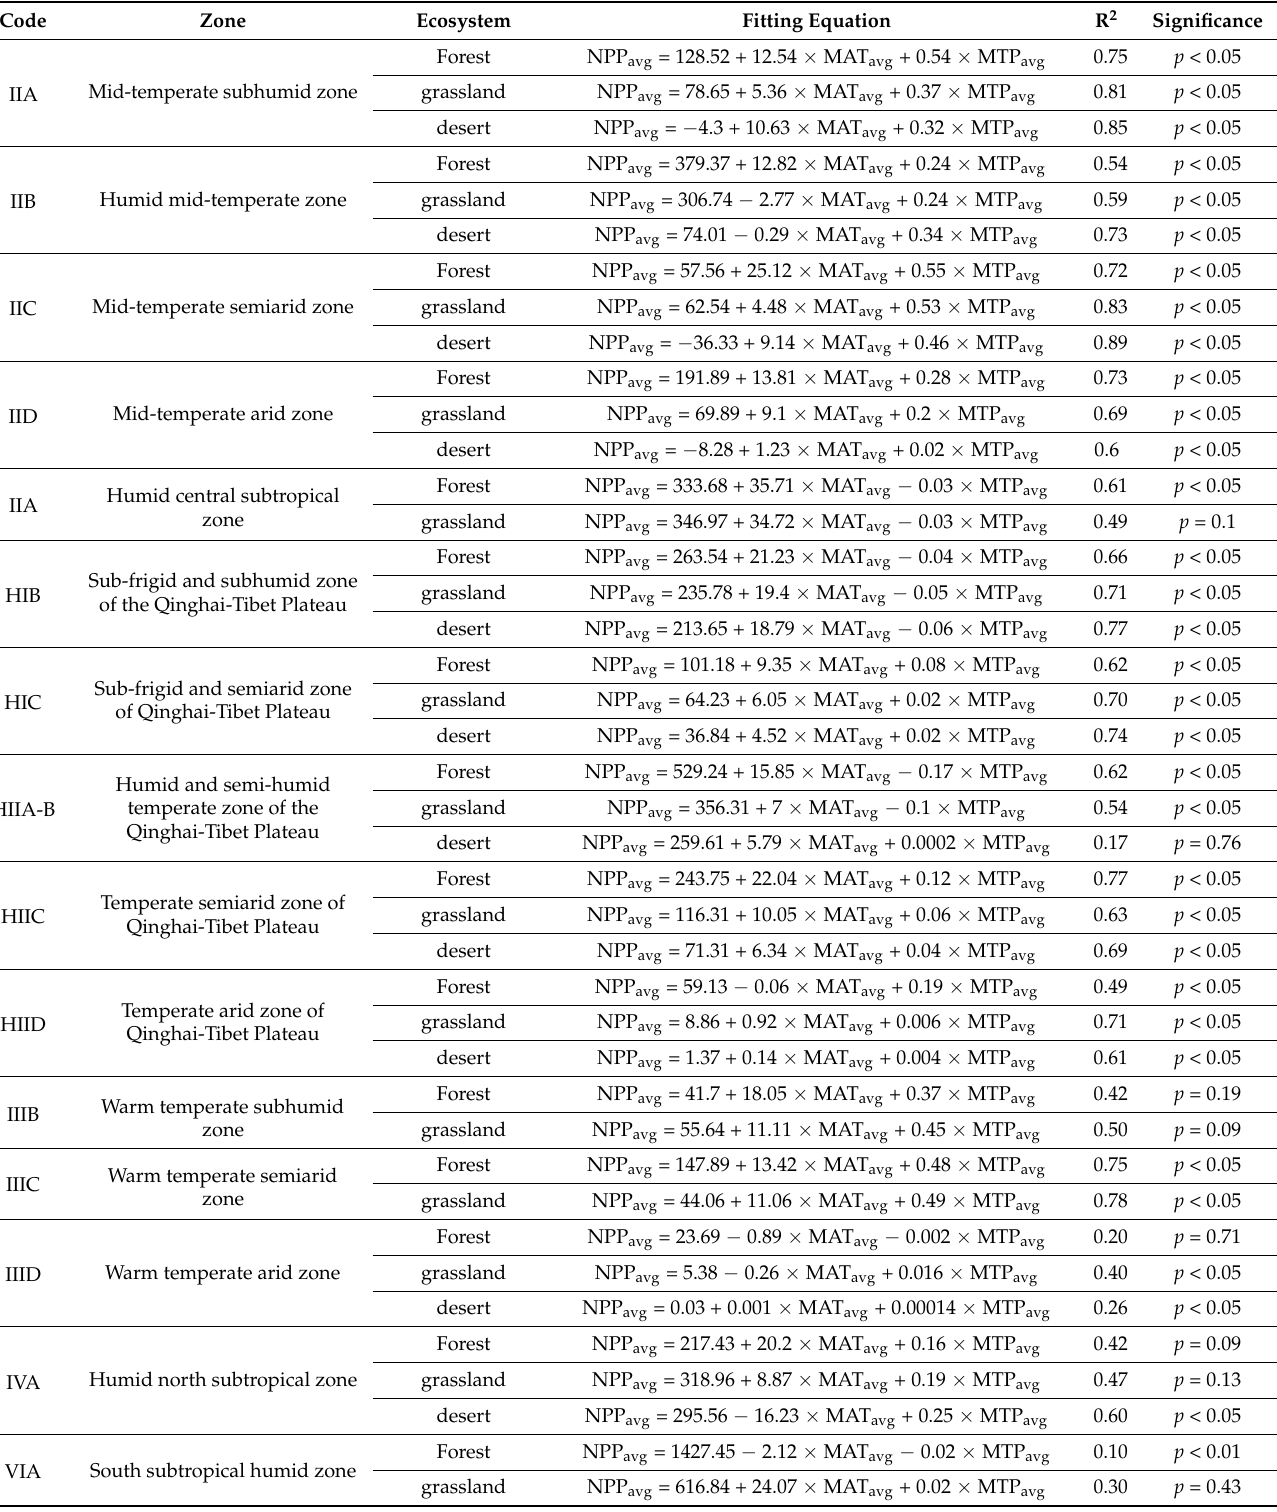
Table 4. The regression equations of NPPavg, MATavg and MTPavg of the climax background of forest, grassland and desert ecosystems in each eco-geographical